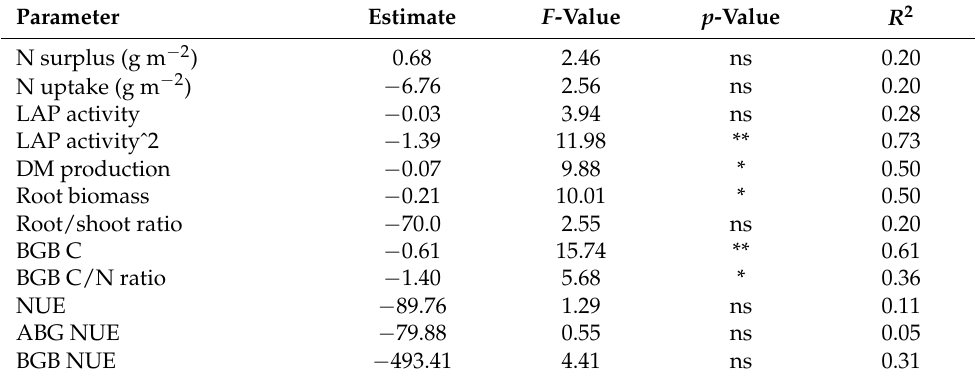
Table 4. Linear effect of the measured biomass traits on N 2 O